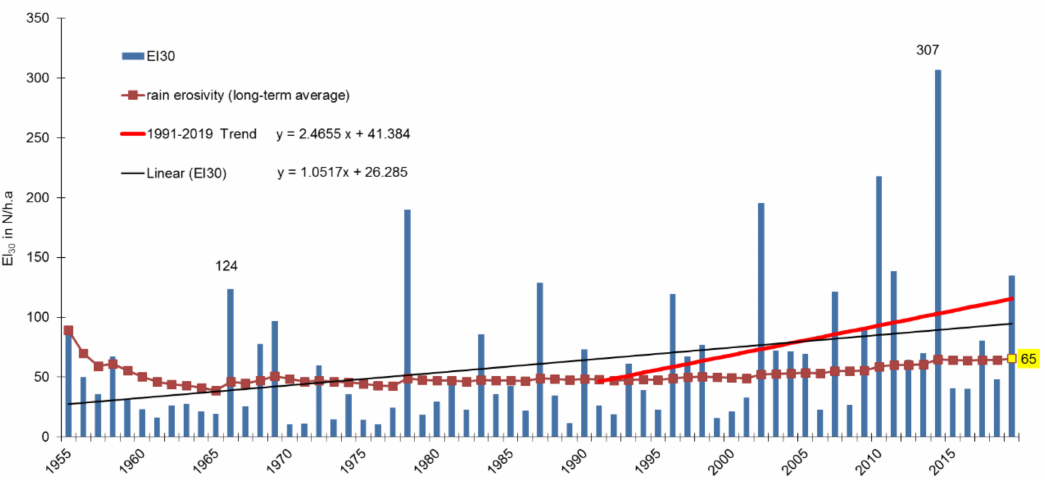
Figure 14. Rainfall erosivity in Müncheberg, with linear trends for 1955–2019 and 1991–2019. EI 30 values for April–October. Long-term mean value in